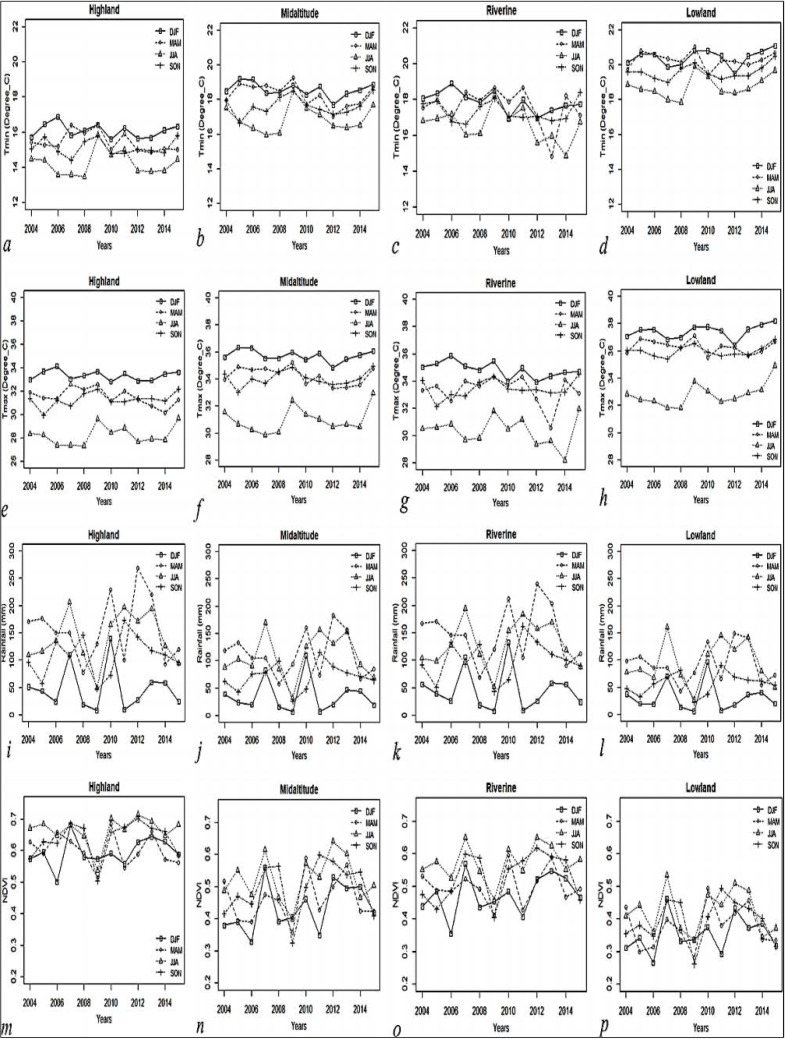
Seasonal trends in Tmin (A-D), Tmax (E-H), rainfall (I-L), and NDVI (M-P).